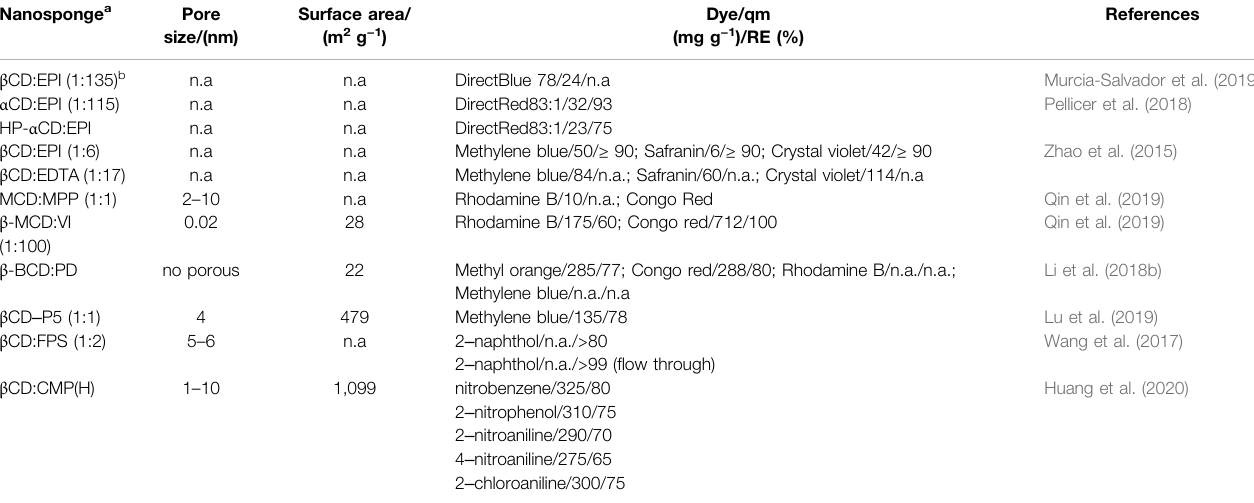
TABLE 5 | Selected examples of nanosponges application for dye removal. Nanosponge